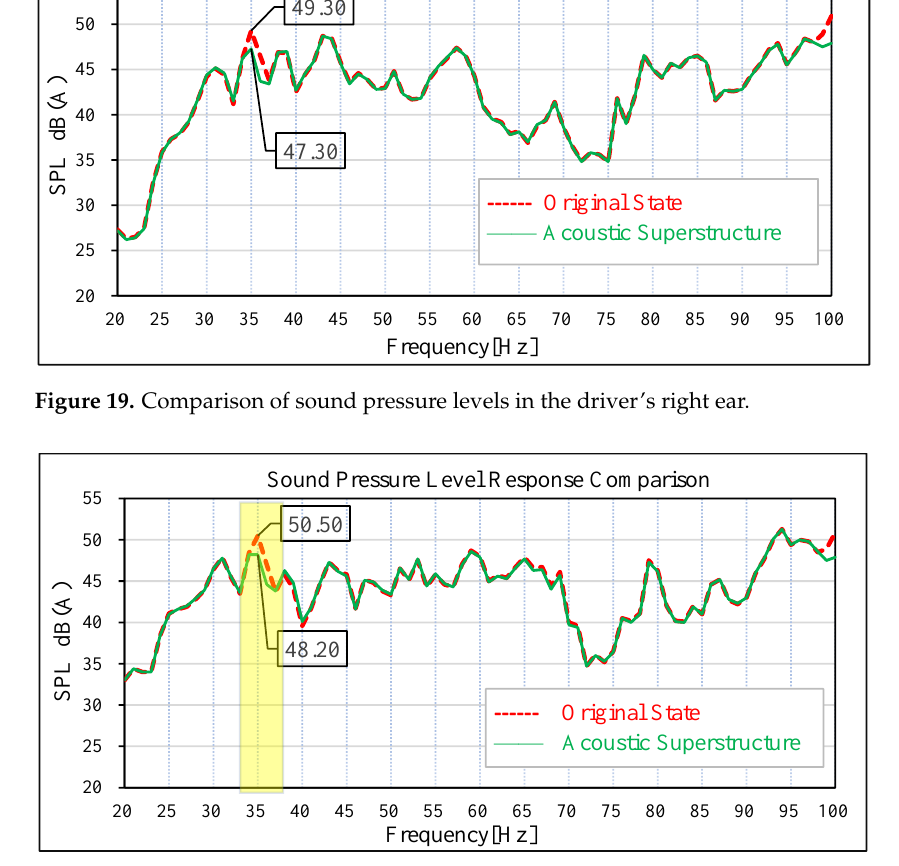
Figure 21. Comparison of x-direction vibration response of sheet metal parts of the tail door. Figure 22. Comparison of z-direction vibration response of sheet metal parts of tail door. In the original state without an acoustic metamaterial attached, the sound pressure level at the driver’s right ear and the middle seat of the rear passenger’s seat has an obvi- ous peak value at 35 Hz; the amplitude of the sound pressure level of the driver’s right